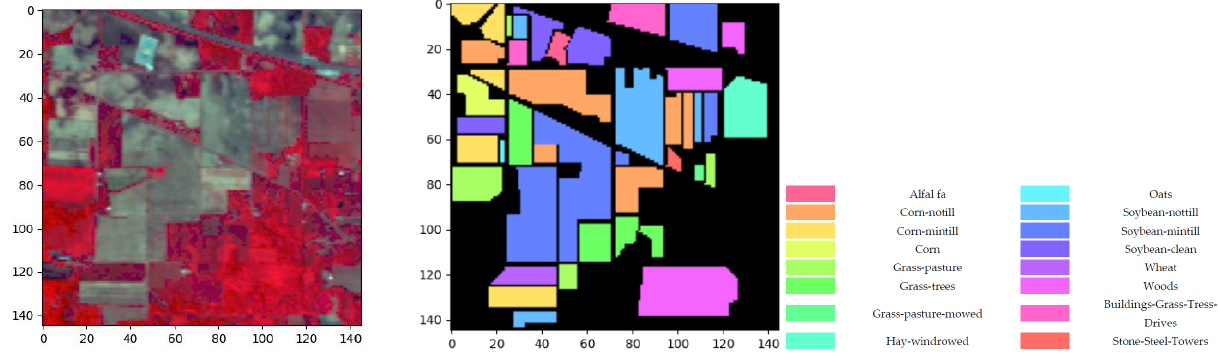
Figure 5. Pseudo-color image (R: 50, G: 30, B: 20) and ground truth of Indian Pines dataset.